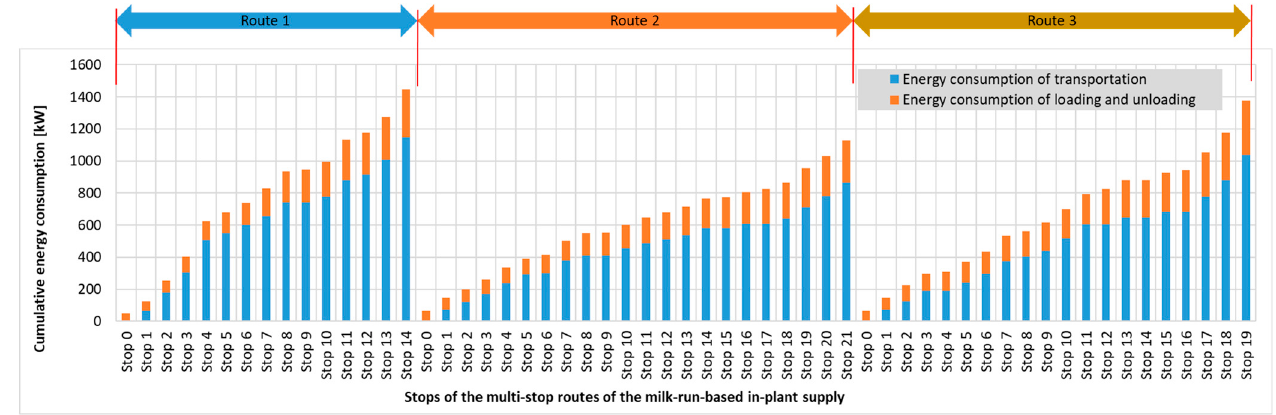
Figure 15. The cumulative energy consumption of the three milk-run trolleys.